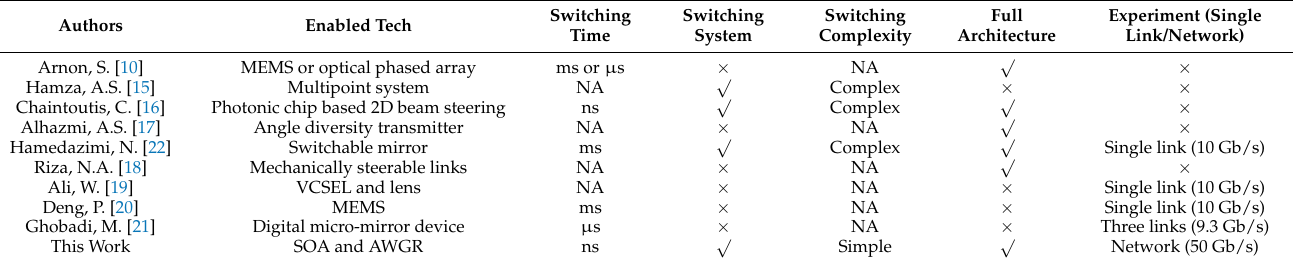
Table 4. Comparison of the research on optical wireless